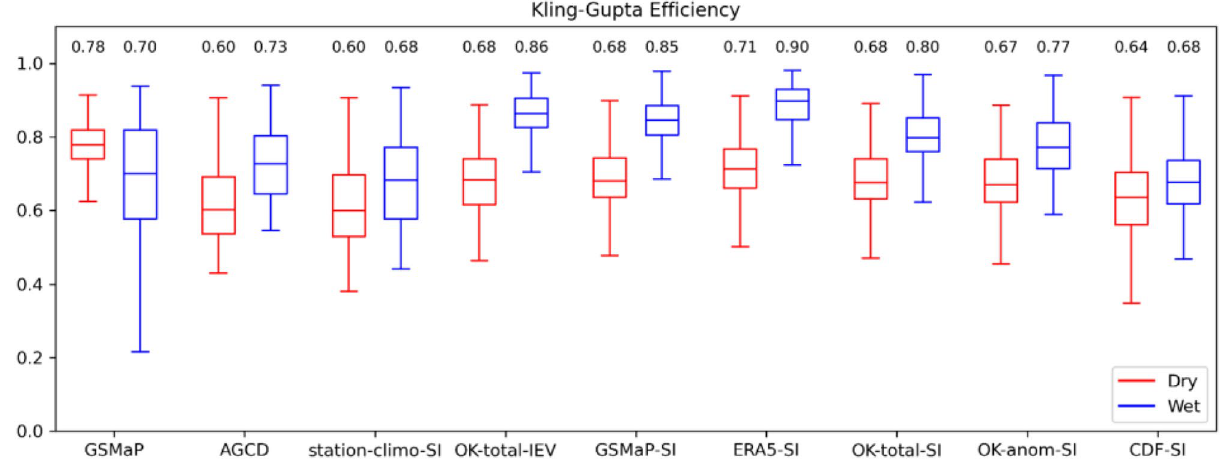
Figure 7. Boxplots of KGE across the datasets for a gauge-sparse sub-domain. The validation was split into the wet and dry seasons as well. A value of unity is ideal.